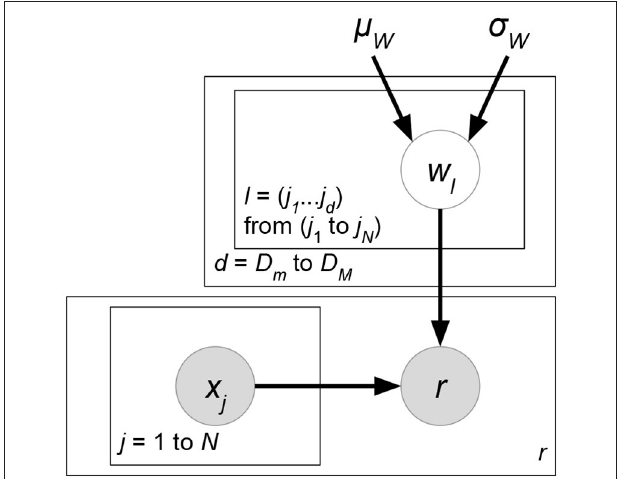
FIGURE 13 | w -weighted